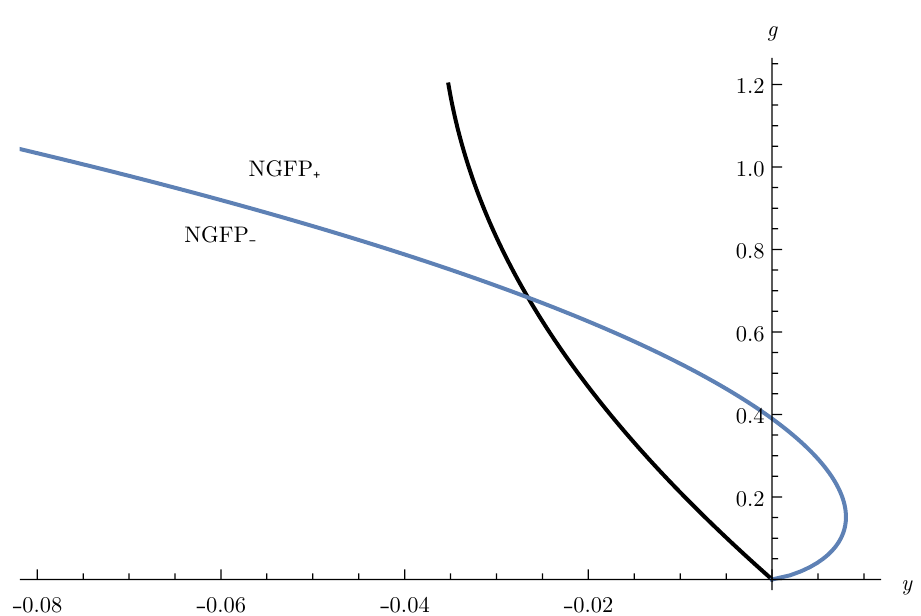
Figure 9 . Behavior of the RG trajectories passing through y - g -plane situated at (cid:21) = (cid:0) 0 : 1. Tra- jectories passing the plane above (below) the blue line emanate from NGFP + (NGFP (cid:0) ) while the high-energy behavior of trajectories building up the blue line is governed by the NGFP 0 . Trajecto- ries for which lim k ! 0 Y k = 0 are indicated by the black